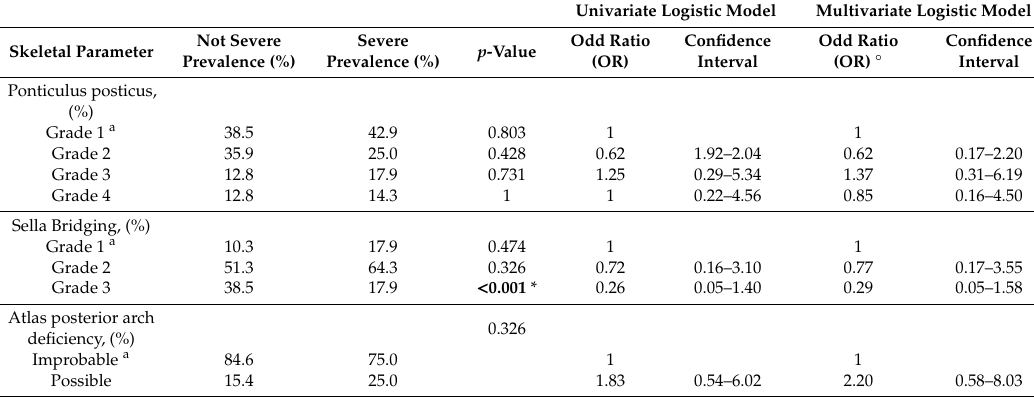
Table 6. Descriptive statistics and results of univariate and multivariate logistic analysis with not severe / severe maxillary canine impaction (MCI) for the following skeletal parameters: PP, SB and